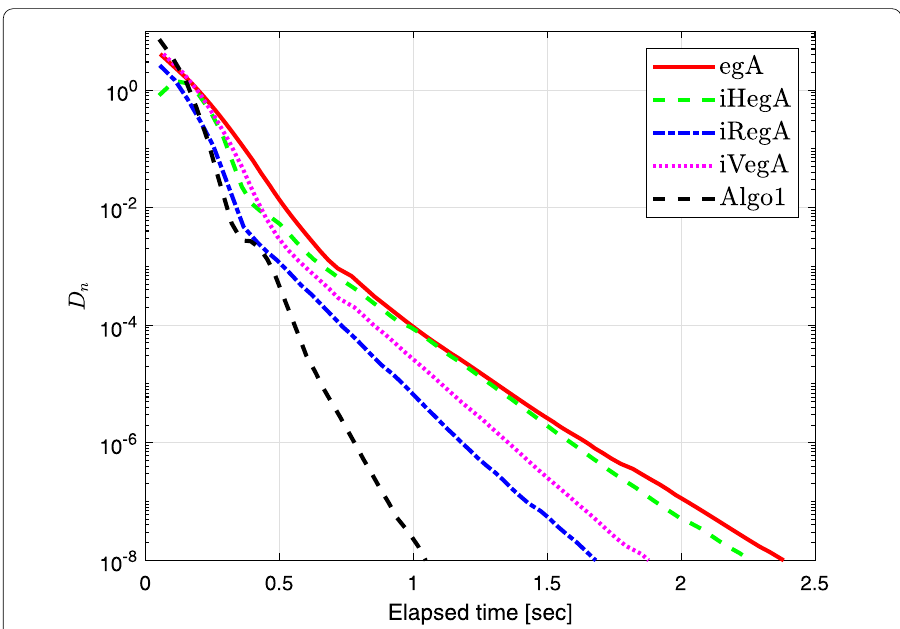
Figure 10 Example 5.3 when x 0 = (1,2,3,4,0) T : the number of iterations is 73, 67, 50, 46, 42, respectively